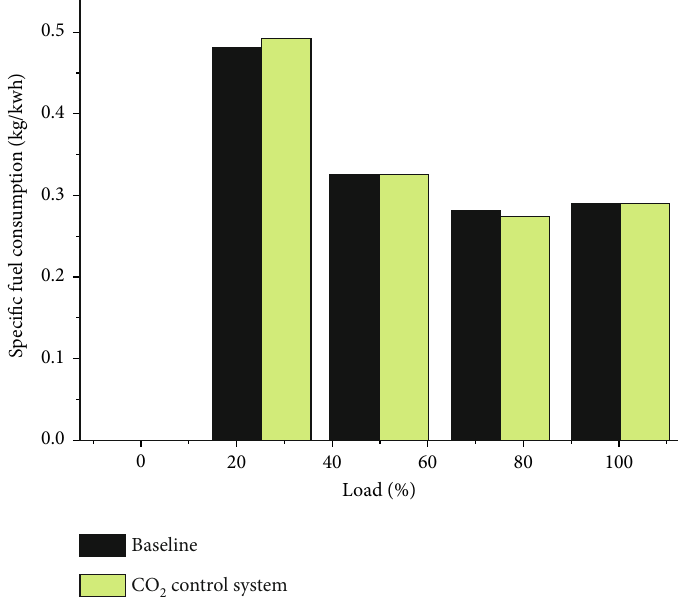
Figure. 8: E ff ect of CO